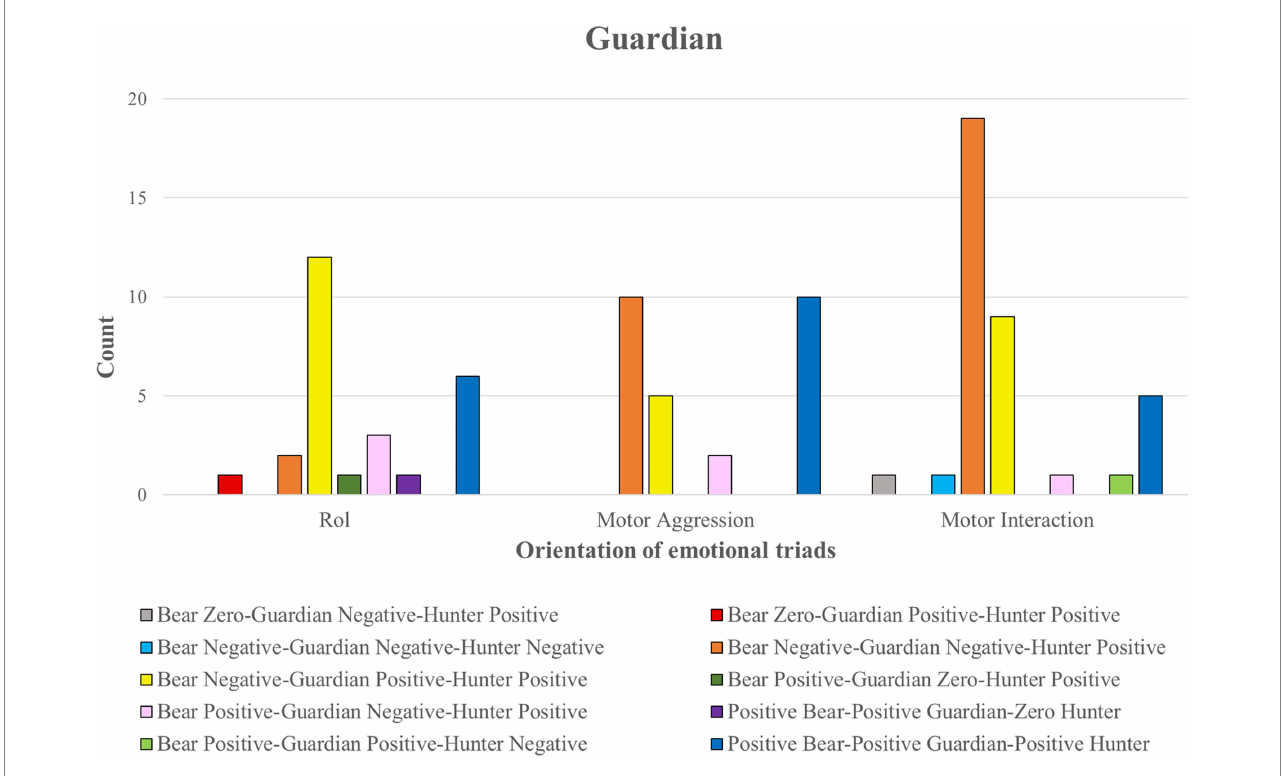
FIGURE 10 Orientation of emotional triads in the Hunter